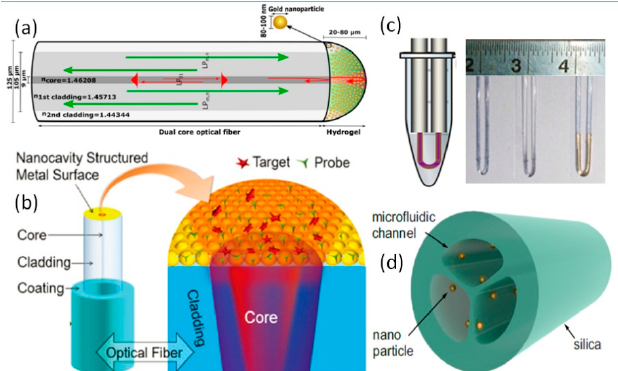
Figure 3. Metal NPs elaborated ( a ) fiber end using dip-coating [28]; ( b ) fiber end using self-assembly method [29]; ( c ) U-shaped fiber [40] and ( d ) air hole of PCF [41].